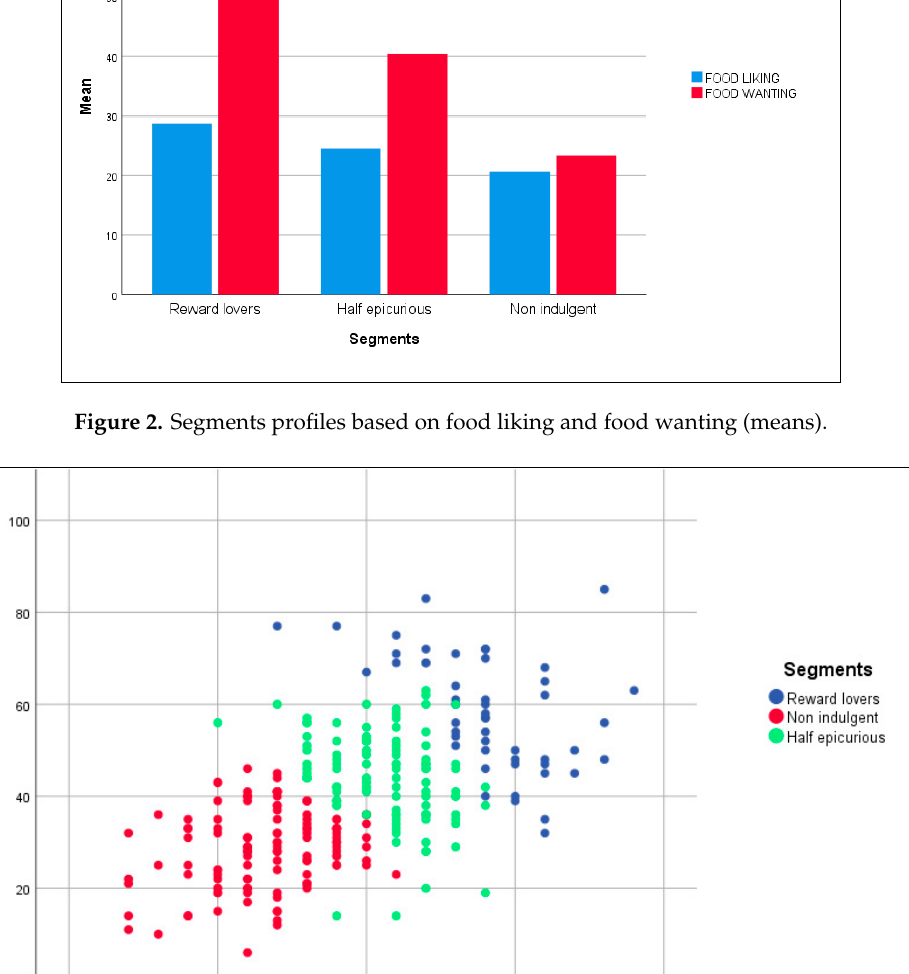
Figure 4. Segment’s food choice. Pure virtue-pure vice set (number of respondents).